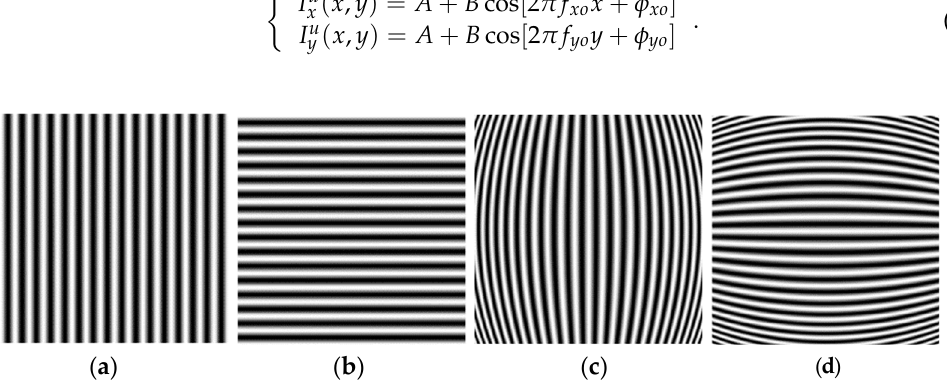
Figure 2. Sinusoidal fringe-patterns before and after barrel distortion. ( a ) Undistorted longitudinal fringe-pattern; ( b ) Undistorted transverse fringe-pattern; ( c ) Distorted longitudinal fringe-pattern; ( d ) Distorted transverse fringe-pattern.